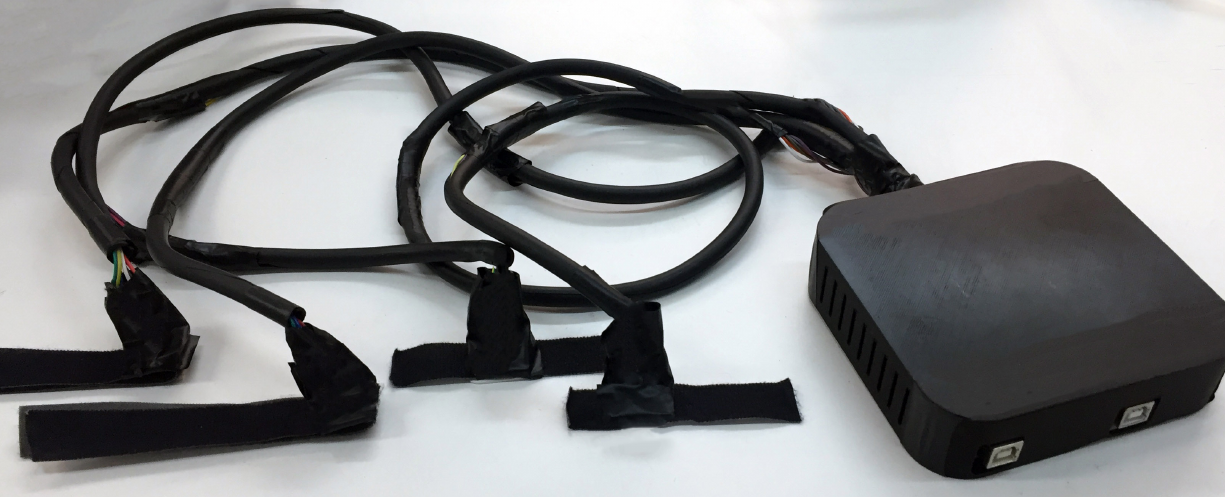
Figure 7. The accelerometer signal acquisition